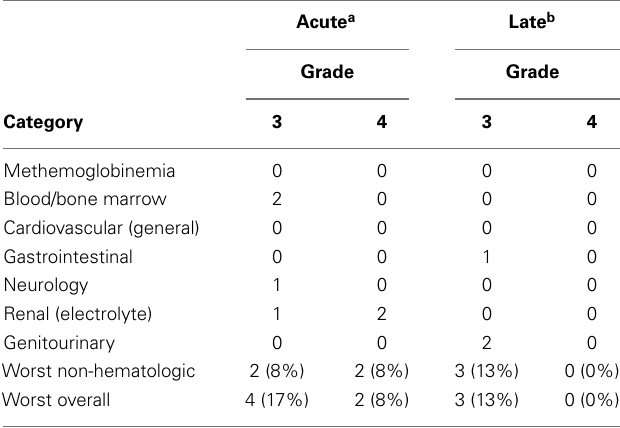
Table 2 | Protocol-defined triapine-attributed treatment adverse events occurring at any time ( n = 24)